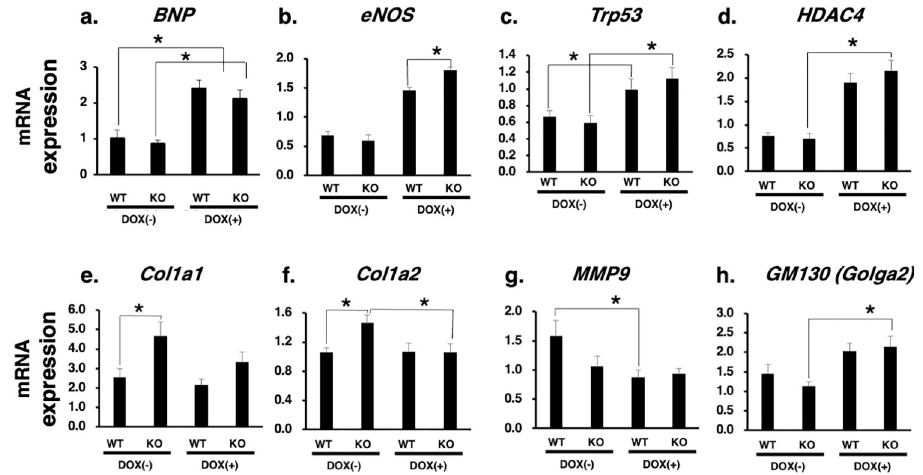
Fig 4. Gene expression profiling of Zip13 -KO mice heart tissues. The expression of genes related to cardiomyocyte function (a: BNP ; b: eNOS , c: Trp53 , d: HDAC4 , e: Col1a1 , f: Col1a2 , g: MMP9 , and h: GM130 ) was analyzed in heart tissue samples derived from WT and Zip13 -KO mice, with or without Dox administration. Each gene was quantitatively analyzed using qPCR. Significant differences were analyzed using the Student’s t-test, � p < 0.05, n = 3–4.